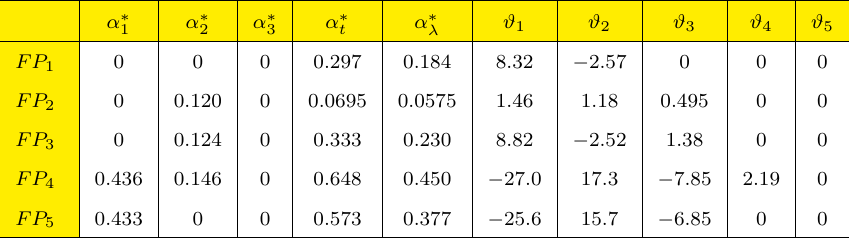
Table 2 . Fixed points and their scaling exponents for the SM in the 321 approximation